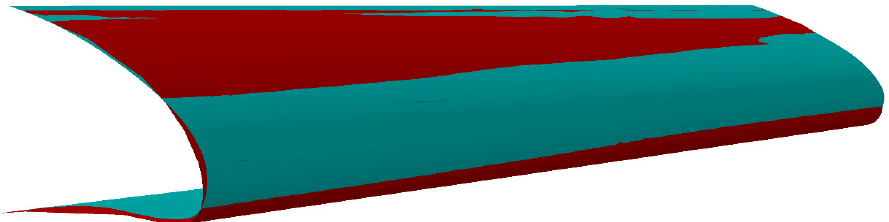
Figure 20. Comparison between deformation and the target shape.